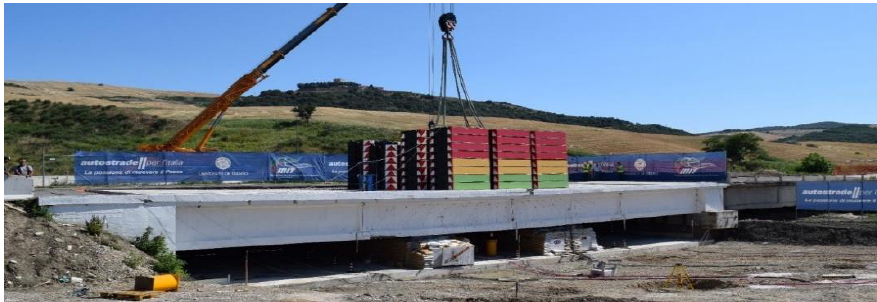
Figure 8. The Alveo Vecchio viaduct during the loading phase 5, loaded with 93 weights — 9300 kN.